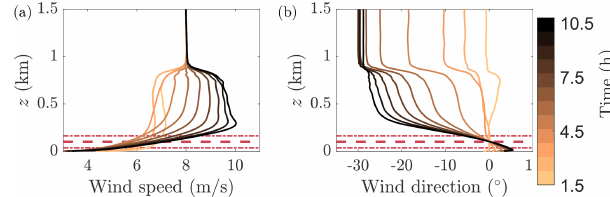
Figure 3. Diurnal cycle flow (a) wind speed and (b) wind direc- tion, α ( z ) − α ( z h ), as a function of height z , where z h is the wind turbine hub height. The profiles are 30min averages at hourly inter- vals throughout the 12h simulation, with lighter colors near the ini- tialization (unstable ABL) and darker colors corresponding to later times of the simulation (stable ABL). The simulation is initialized at time t = 0 corresponding to 18:00. The horizontal dashed line corresponds to hub height, and the horizontal dashed dotted lines are the rotor